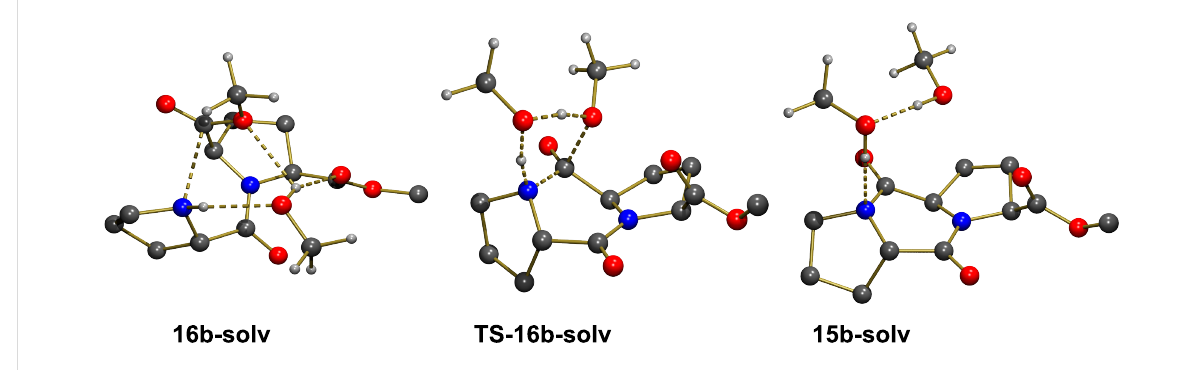
Figure 3: Optimized geometries of the extrema located along the pathway for formation of 15b with explicit participation of one solvent molecule. Most H atoms were omitted for clarity.